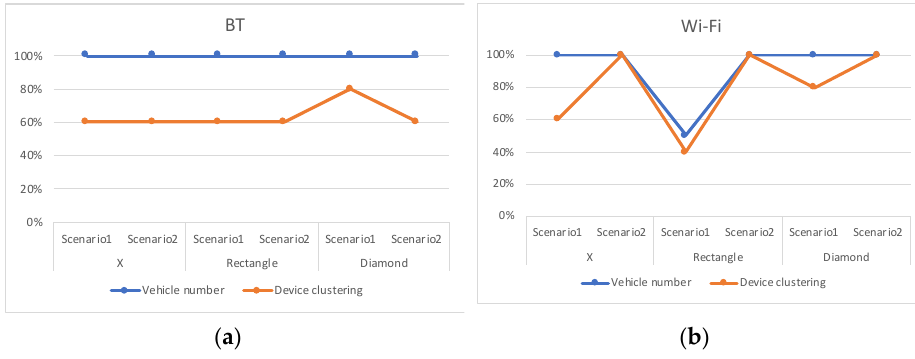
Figure 17. Accuracy of MDP comparison on different topologies: ( a ) accuracy of MDP in Bluetooth; ( b ) accuracy of MDP in Wi-Fi.